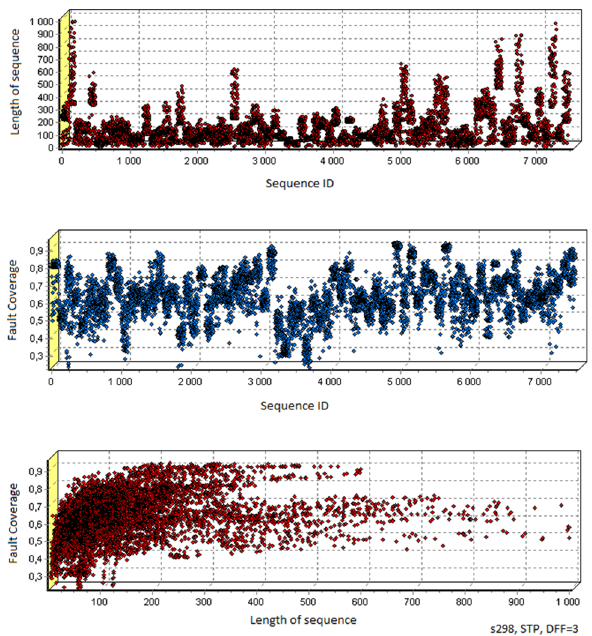
Fig. 24 STP for s298 with use of 3 internal flip-flops